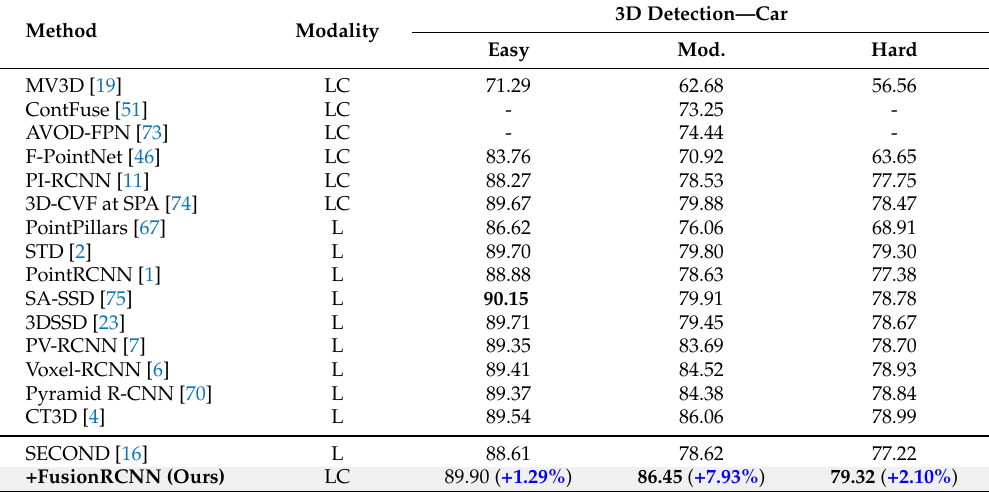
Table 4. Results on KITTI val . AP(Average Precision) with 0.7 IoU threshold and 11 recall positions are reported. L denotes LiDAR-only approaches. LC denotes the methods that combine LiDAR point clouds and camera images. The best results are bolded and performance improvements are painted in blue.